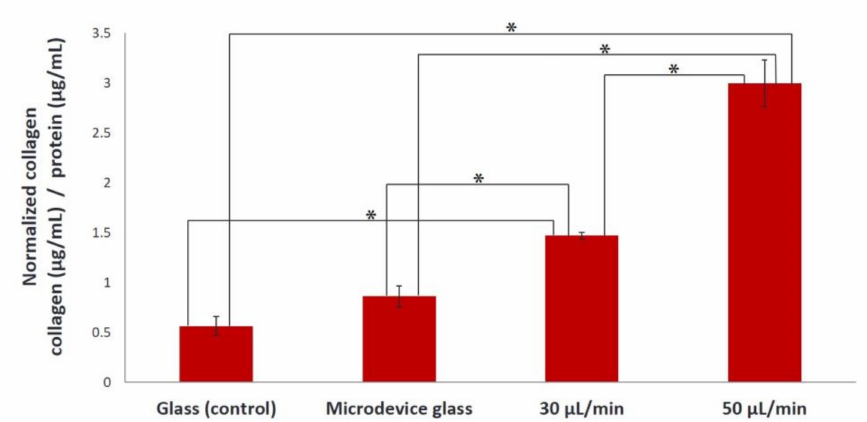
Figure 3. Normalized levels of collagen secreted by MC3T3-E1 cells on gelatin substrates after 7 days of culture under static conditions (glass and microdevice glass) and under flow conditions (flow rates of 30 and 50 µ L/min). A * p value of < 0.05 was considered significant.